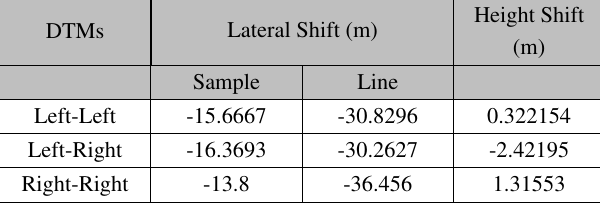
Table 2: The shift values of the DTMs with respect to LOLA tracks